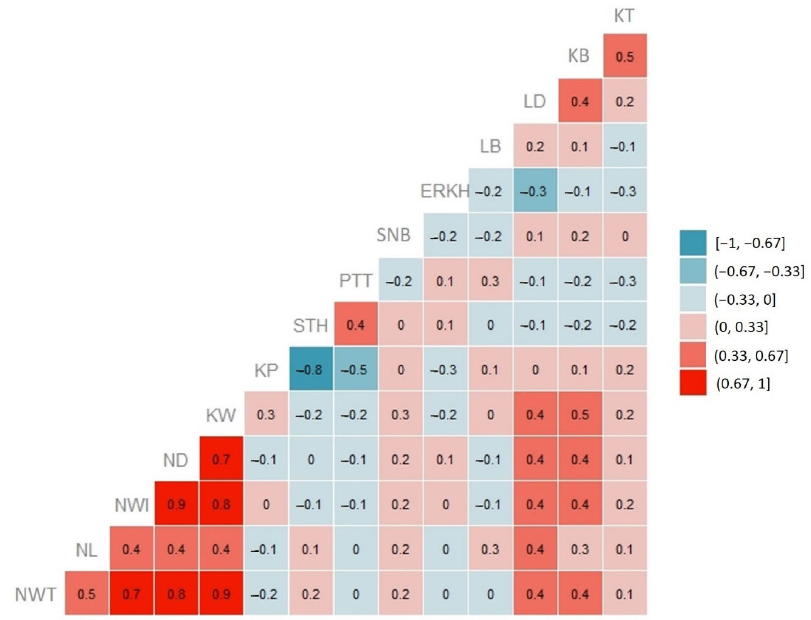
Figure 4. Heatmap of Spearman’s correlation coefficients between phenological, pomological, and taste traits within the studied walnut genotypes.